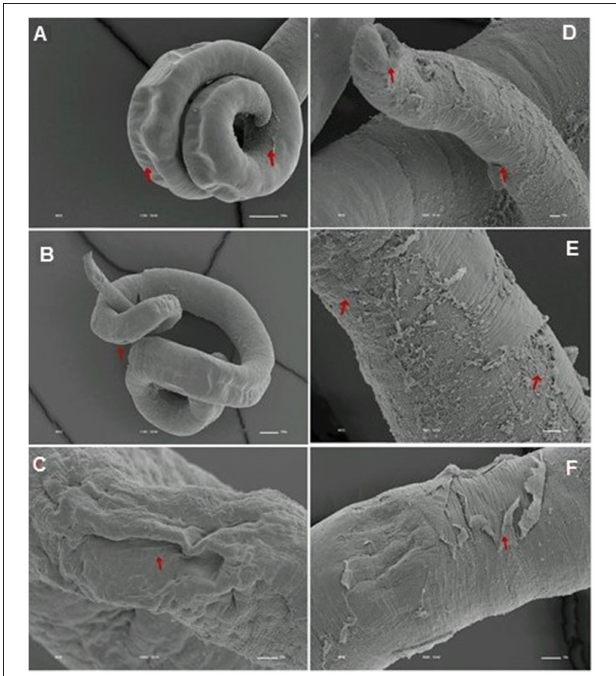
FIGURE 9 | Scanning electron microscopy of S. mansoni PZQ-resistant strain adult males of control group kept in RPMI-1640 drug free medium for 3 h. (A,B) Resistant strain adult males kept in RPMI-1640 drug free medium, showing normal morphology of the oral and ventral suckers; (C–F) normal morphology of the tegument. Image marginations: (A) 70x 10 kV ________100u; (B) 170x 10 kV ________100u; (C) 1200x 10 kV ________10u; (D) 950x 10 kV ________10u; (E) 2200x 10 kV ________10u; (F) 850x 10 kV